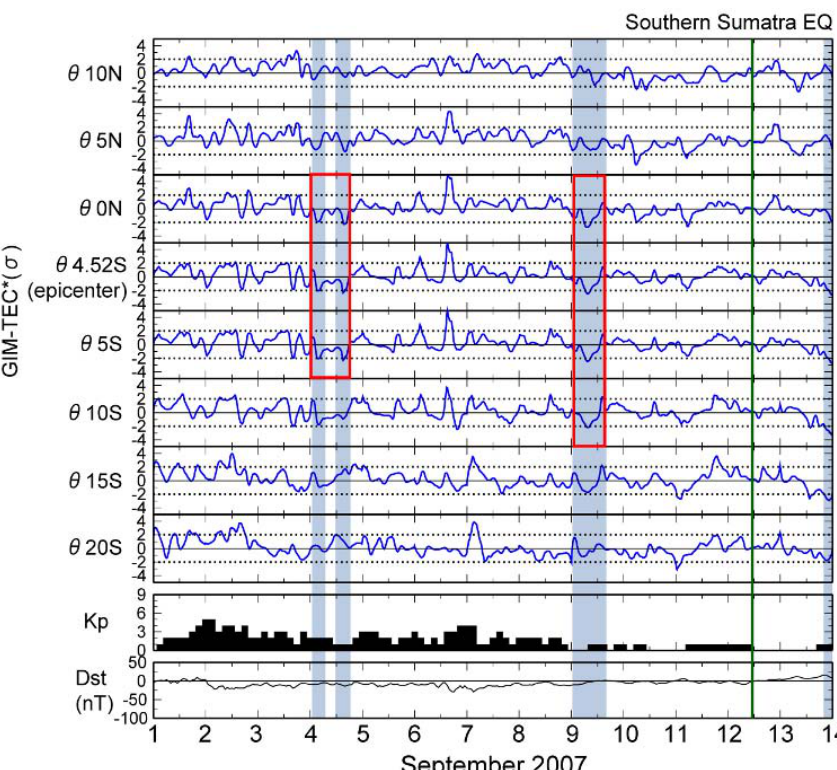
Fig. 6. Variations of GIM-TEC*, K p index, and Dst index from 1 September to 13 September 2007 for various latitudes. The solid green line shows the time at which the earthquake occurred. The blue areas indicate periods during which a significant decrease in GIM-TEC* over − 2 σ occurred at multiple stations. Red frames mark significant decreases in GIM-TEC* around the